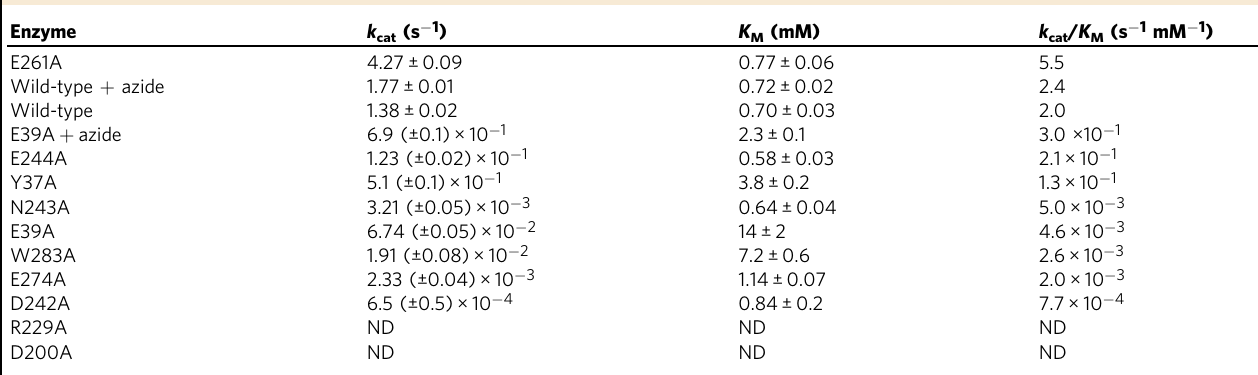
Table 1 Kinetic parameters of AlfC WT and point